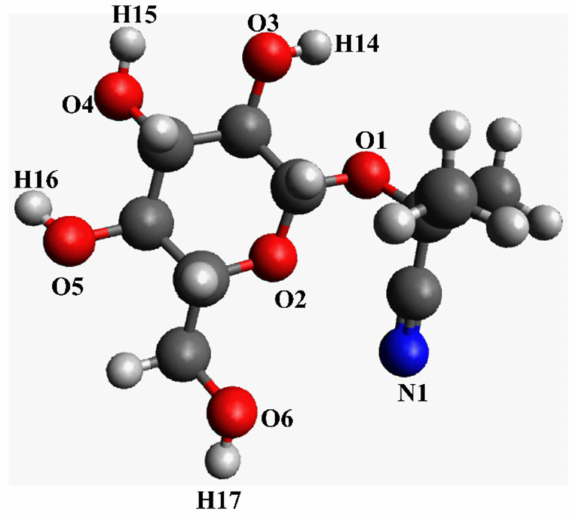
Figure 2. Chemical structure of linamarin (simple drawing for illustrative